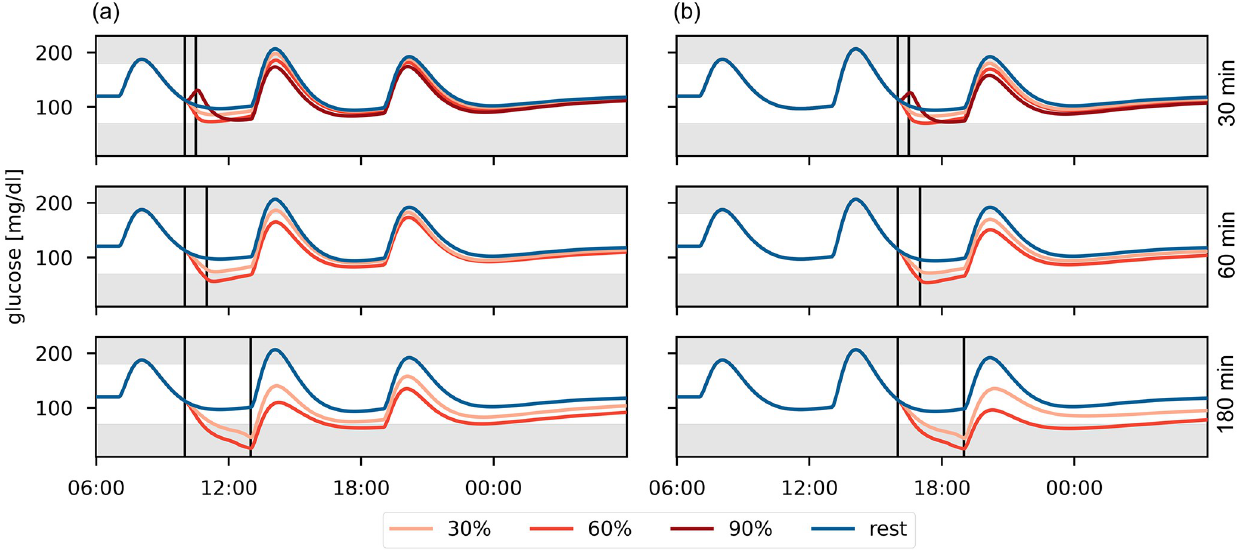
Fig 4. Comparison of glucose trajectories for different PA scenarios in a full-day simulation. PA is performed at 30%, 60% and 90% VO max and 180 minutes (a) in the morning, or (b) in the afternoon. The PA session is marked by vertical lines. Meals are eaten at 7:00, 13:00 and 19:00 containing 40g, 60g and 50g CHO,